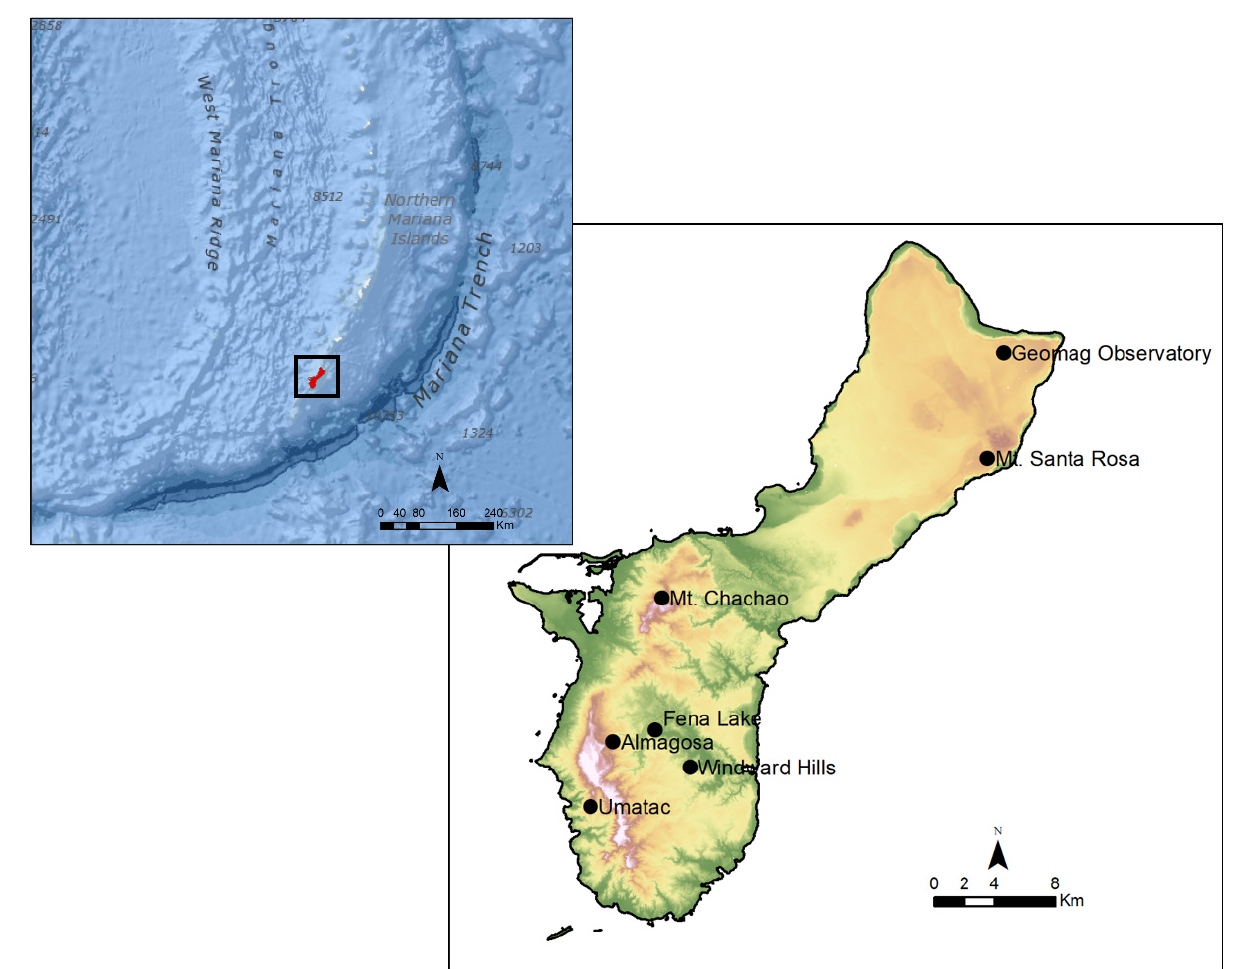
Figure 2. Geographical information on the study area. Upper map shows the location of Guam in the Mariana region, and the bottom map shows the digital elevation map. Black points denote the rain gages used in this study. Sources for World Ocean Reference and Bases in the upper map are Esri, GEBCO, NOAA, National Geographic, Garmin, HERE, Geonames.org, and other contributors.